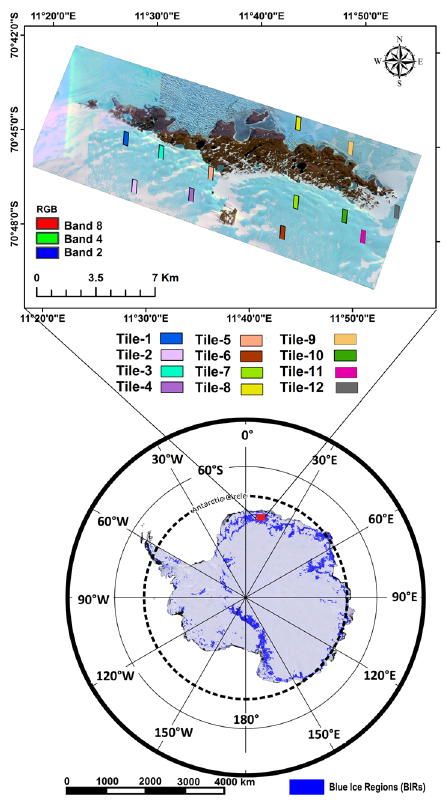
Figure 1. Location of the Schirmacher Oasis depicted on a Landsat image mosaic of Antarctica (LIMA) (https://lima.usgs.gov/, accessed on: 20 January 2022). Antarctic blue-ice regions (BIRs) (Hui et al., [22]) derived using ETM+ and MODIS data are depicted in blue on LIMA. WorldView-2 PAN-sharpened imagery shows the spatial distribution of the 12 tiles considered in this study. Each tile is a small subset of around 200,000 m 2 area on the satellite image.